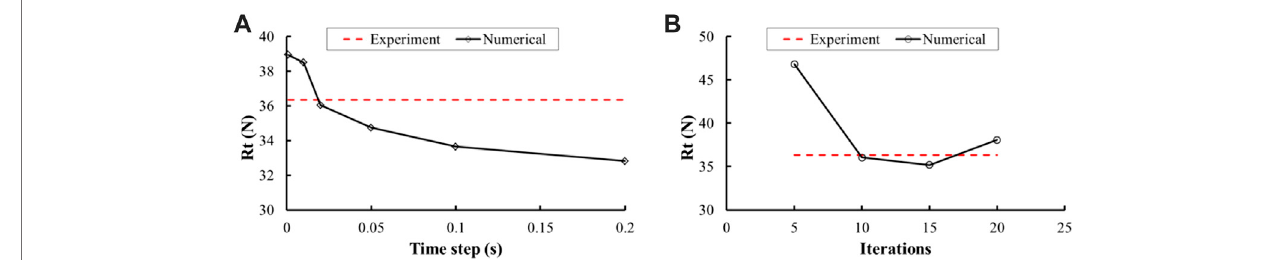
FIGURE 7 | In fl uence of ship – ice friction coef fi cient and iterations.